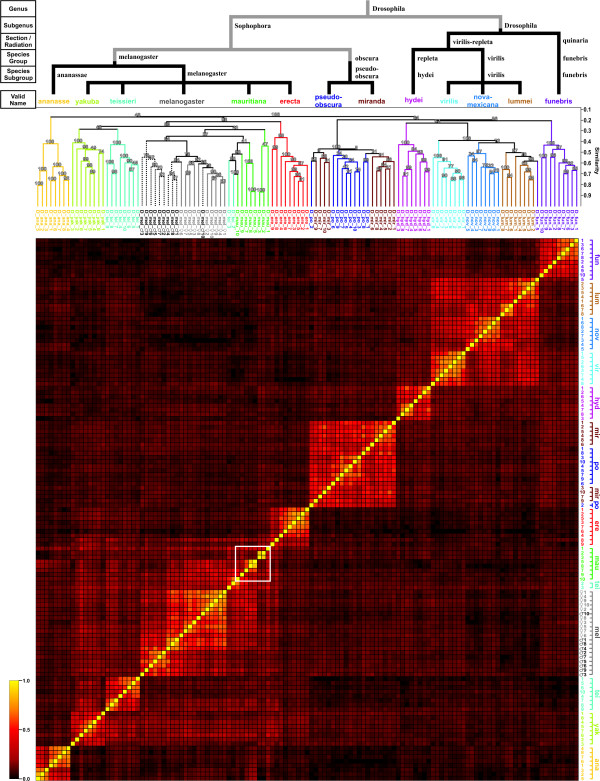
Results from unbiased cluster analysis. 125 spectra from flies of 13 different species were clustered using Dice coefficients. A color (heatmap) representation of the pairwise similarity (Dice) coefficients is shown in the lower part of the figure, the white square outlining the cluster of D. mauritiana spectra. Above this, clustering of individual spectra, color-coded according to species, are shown in a dendrogram. Percentages of bootstrapping replicates supporting the location of individual nodes are indicated. On top of this, a second dendrogram indicating the phylogeny of the different species is shown.